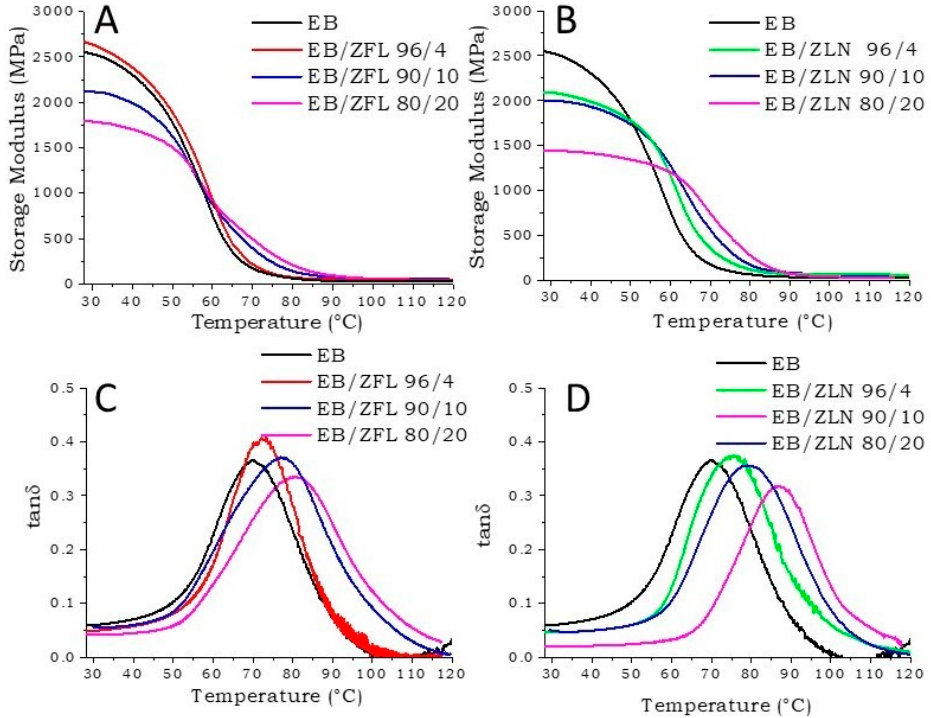
Figure 12. Storage modulus of EB/ZFL ( A ) and EB/ZLN ( B ) composite films containing different amounts of ZnO. Tan δ of EB/ZFL ( C ) and EB/ZLN ( D ) composite films containing different amounts of ZnO.